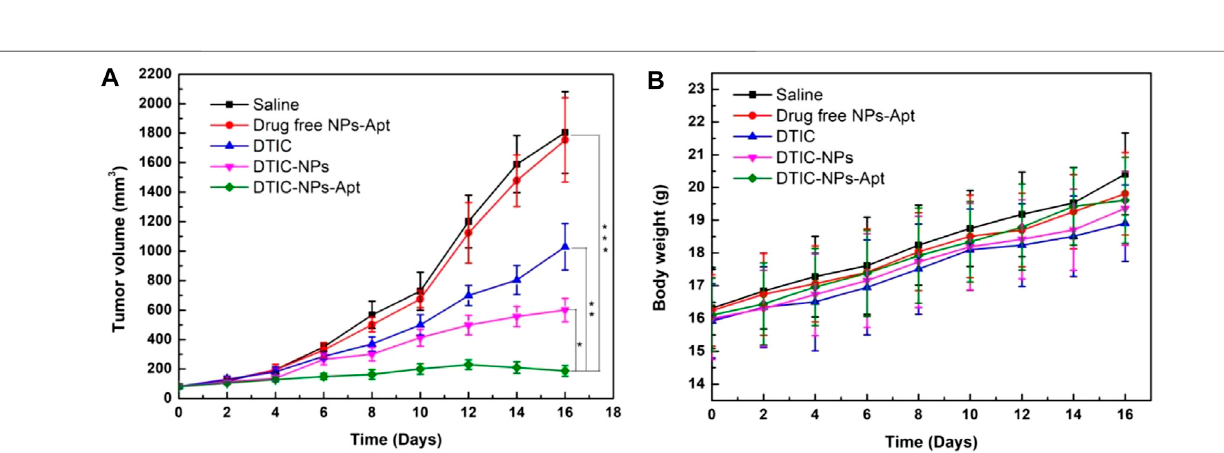
FIGURE 6 | Viability of human melanoma A875 cells cultured with drug free NPs-Apt, free DTIC, DTIC-NPs, and DTIC-NPs-Apt at equivalent drug concentrations rangingfrom0.1to100 μ g/ml.TheamountofdrugfreeNPs-AptwasthesameasthatoftheNPs, n =3. (A) 24 h; (B) 48 h p p < 0.05; pp p < 0.01; ppp p < 0.001indicate signi fi cant difference compared with drug free NPs-Apt.